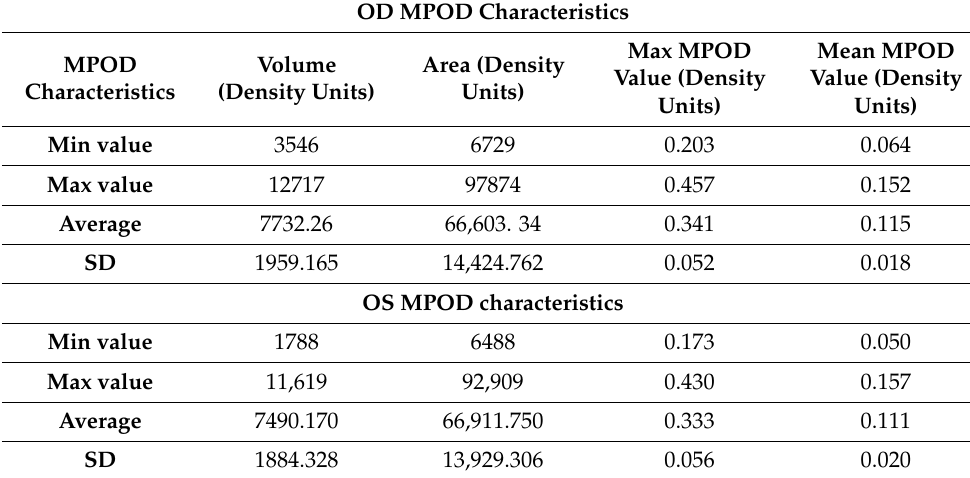
Table 5. Left and right eye MPOD characteristics data.